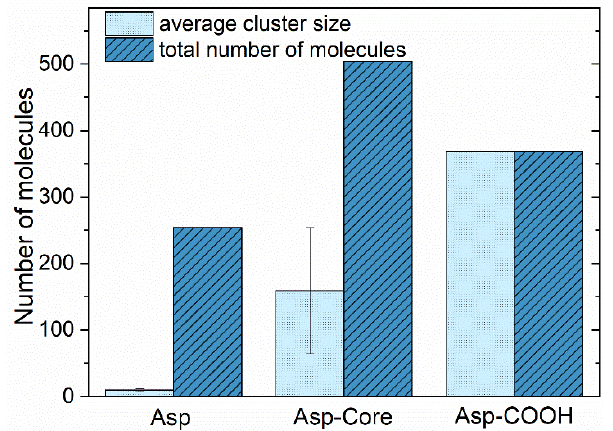
Figure 4. Average sizes of the asphaltene aggregates at the end of the simulations, along with the reference values of the total number of asphaltene molecules in the systems.